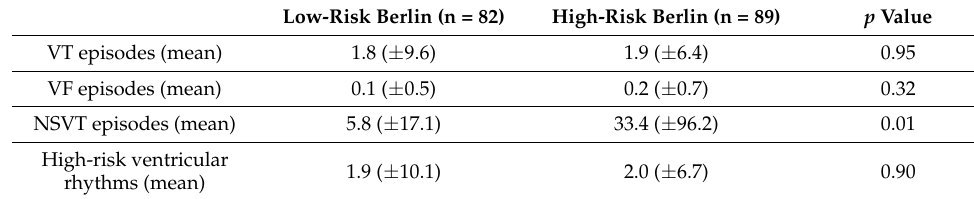
Table 2. Frequency of ventricular arrhythmias.